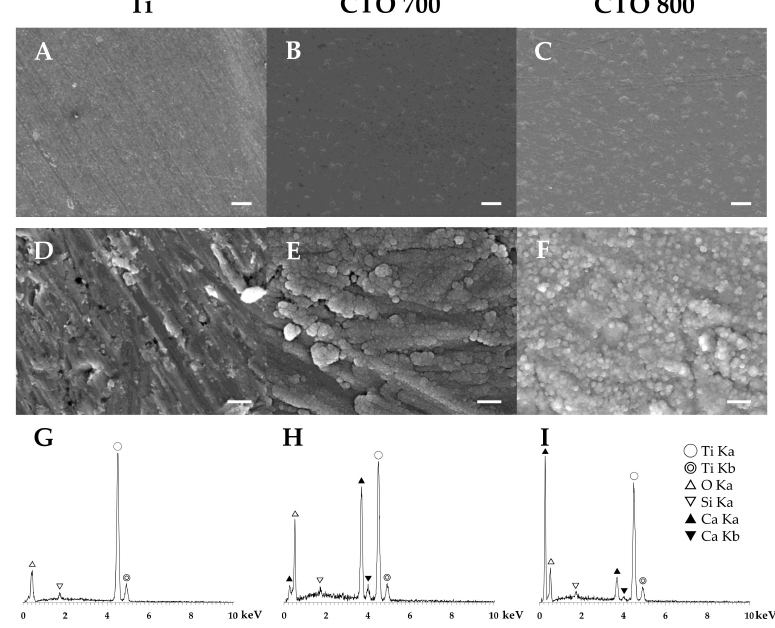
Figure 2. Scanning electron micrographs and energy-dispersive X-ray (EDX) spectra of specimen surfaces. ( A , D , G ) Ti; ( B , E , H ) CTO 700; and ( C , F , I ) CTO 800. EDX spectra ( G – I ) indicate EDX spot elemental analysis sites shown in ( D – F ), respectively. Bars = 100 µ m ( A – C ); 1 µ m ( D – F